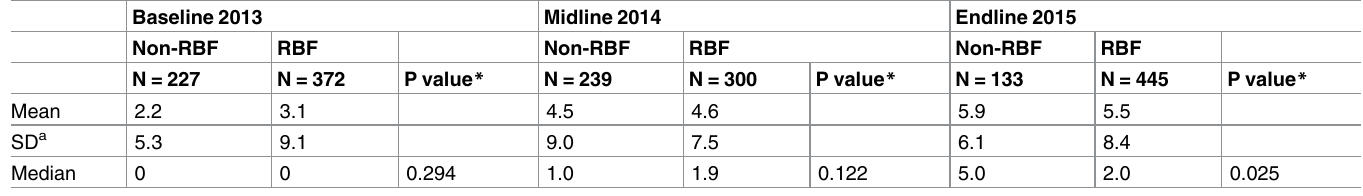
Table 6. Time to seekcare in days among women with self-reported obstetric complications, by group and survey